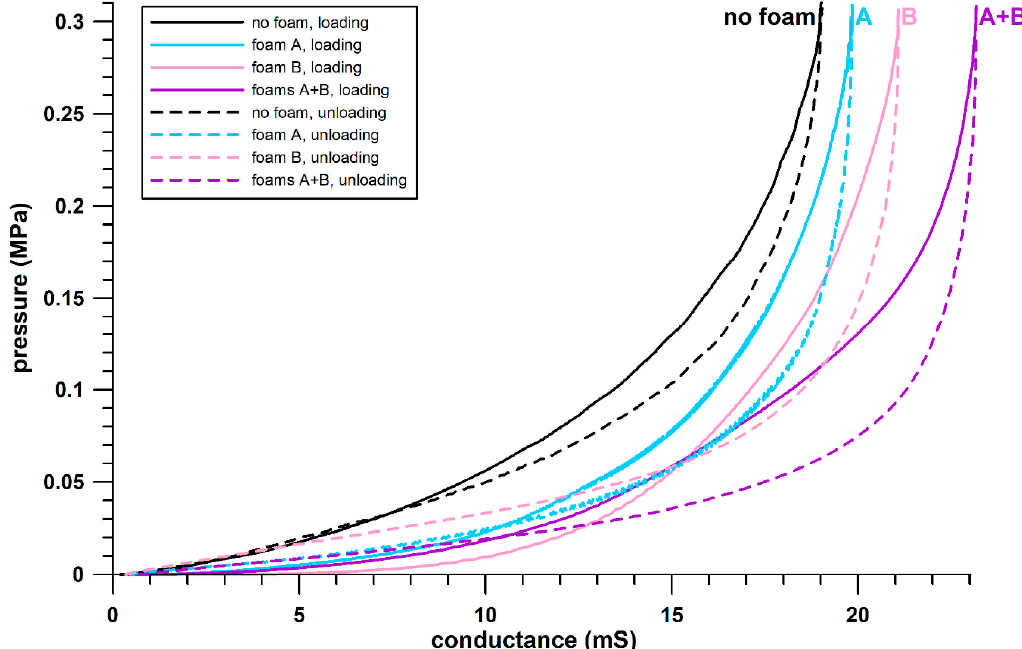
Figure 3. Pressure against conductance of the four sensor-foam configurations; black: no foam; blue: foam A; pink: foam B; purple: both foams with sensor sandwiched between.